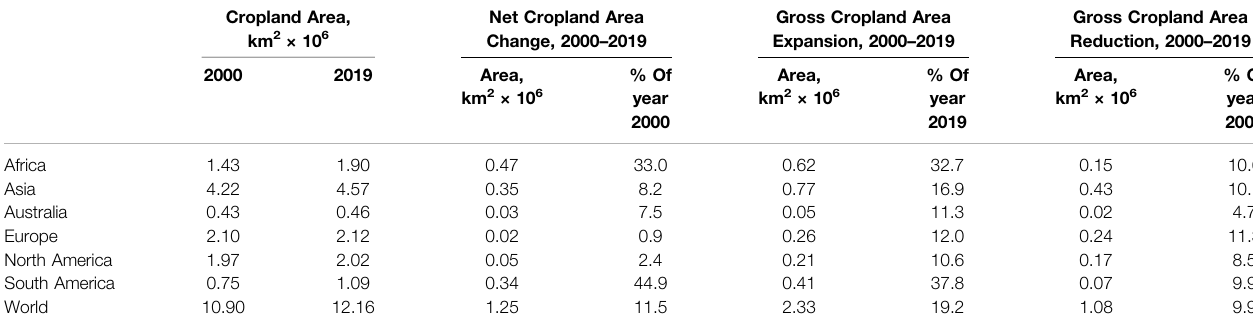
TABLE 3 | Map-based cropland area and change, 2000 –